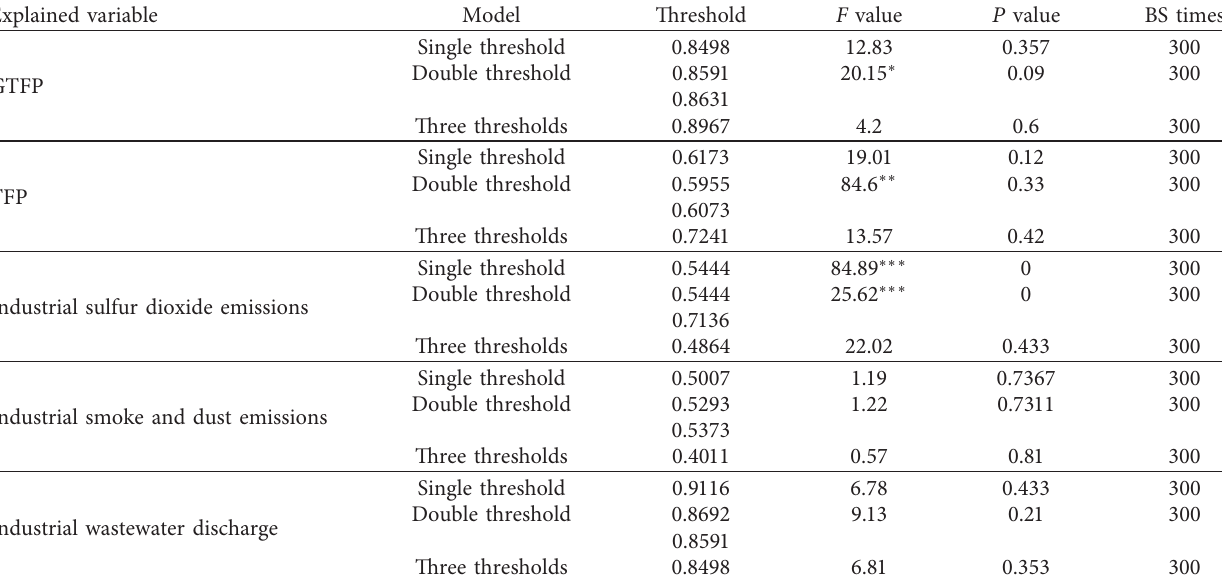
Table 3: The threshold effect test of environmental regulation.